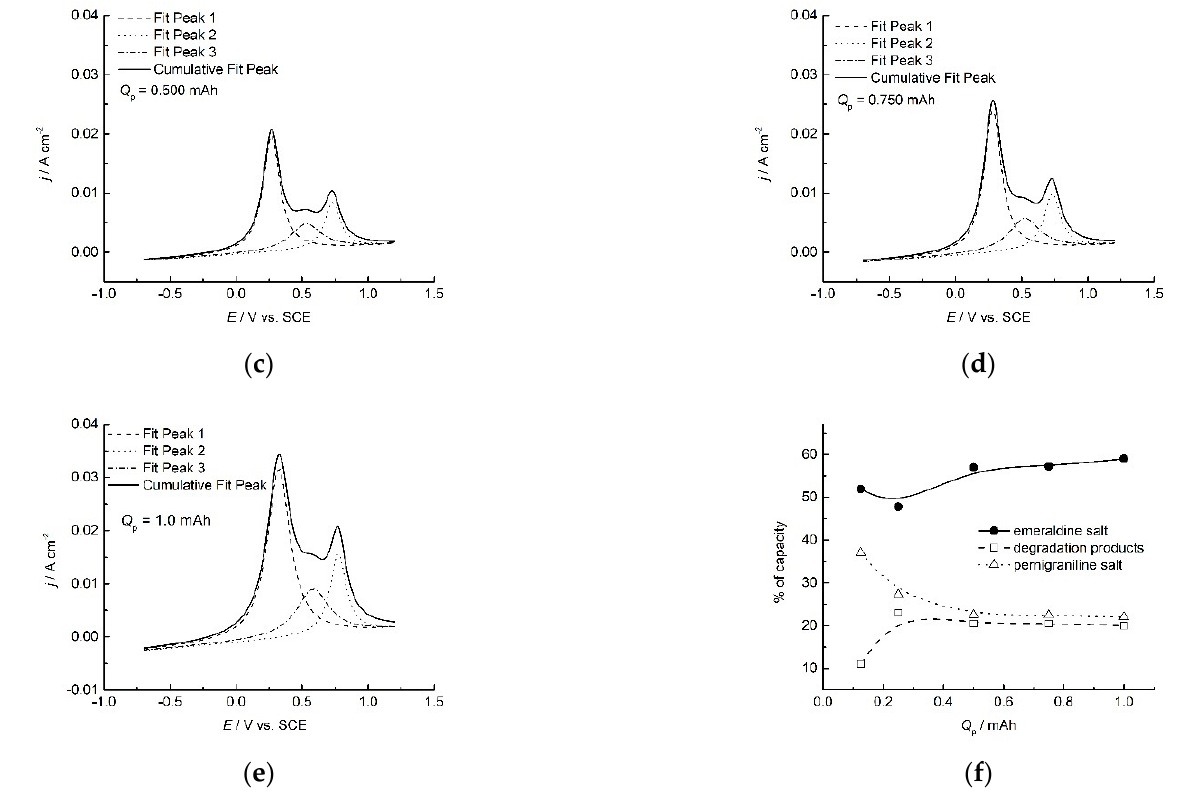
Figure 5. Deconvolution of cyclic voltammograms from Figure 4 for PANI electrodes obtained with different polymerization charges: ( a – f ) dependence of the extent of the capacity of PANI forms over polymerization charge.